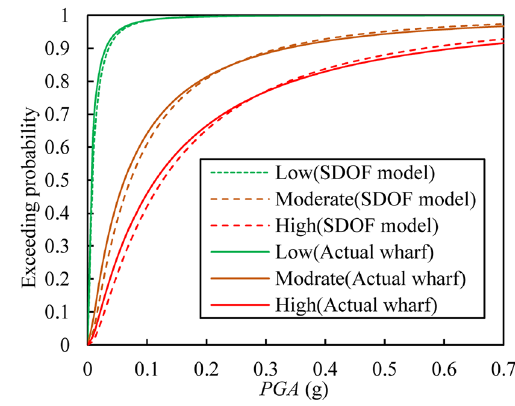
Fig. 9 Fragility curves for case study